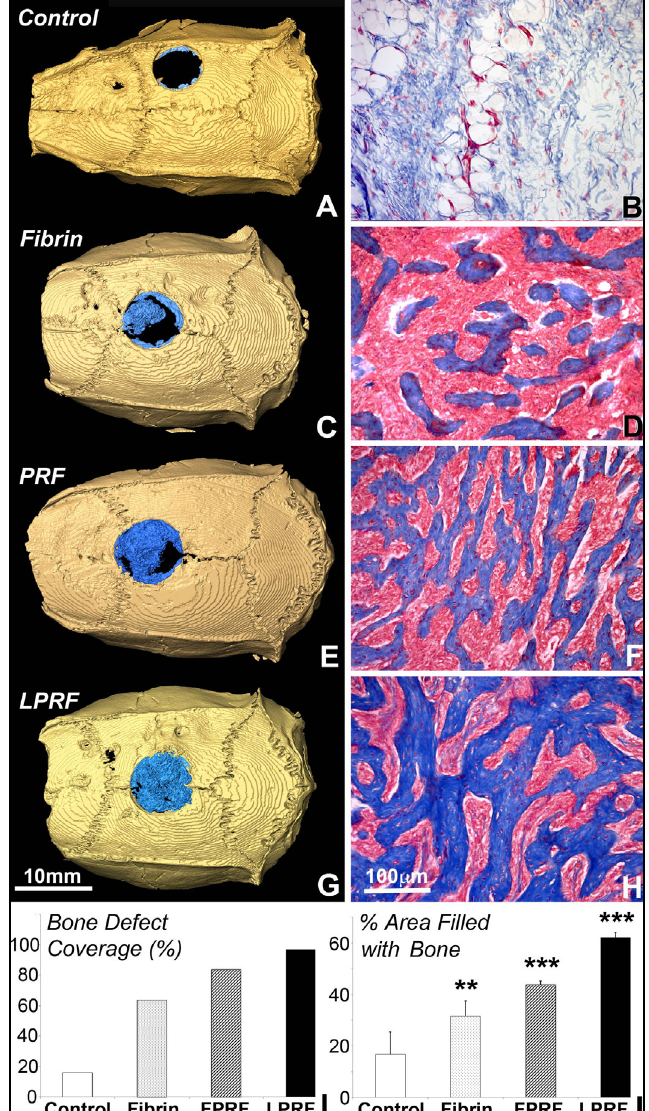
Figure 6. Analysis of bone regeneration in critical size calvarial defects using fibrin gel, fresh and lyophilized PRF as scaffolds. ( A , C , E , G ) are three-dimensional cranial microCT images of control ( A ), fibrin gel ( C ), fresh PRF ( E ) and lyophilized PRF ( G ) after six weeks of implantation. Regenerated bone was visualized in blue; ( B , D , F , H ) are photomicrographs of decalcified paraffin sections through control ( B ), fibrin gel ( D ), fresh PRF ( F ), and lyophilized PRF ( H ) six-week implants stained with Mallory’s procedure. Collagen-containing trabecular bone was stained in blue and fibrin-containing tissue in pink; ( I , J ) illustrate the results from our morphometric analysis of the regenerated tissue covering the calvarial defect; ( I ) documents the relative calvarial defect area by dividing the original area of the defect with a diameter of 5 mm by the area covered in the control, fibrin gel, fresh and lyophilized PRF treatment groups, and ( J ) represents the morphometric analysis of bone versus fiber ratio in all four groups. ** : p < 0.01, and *** : p <